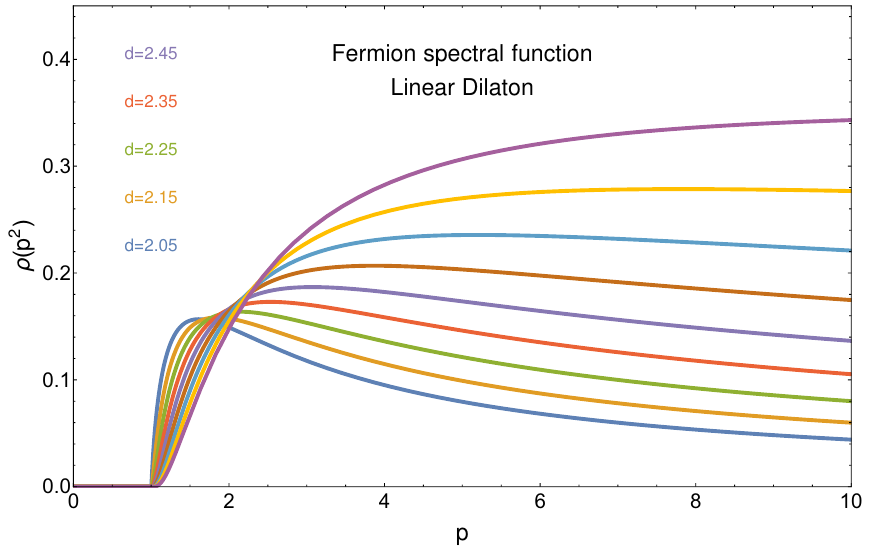
Figure 3 . The spectral density for a continuum Weyl fermion modeled in a linear dilaton back- ground. The quasi-anomalous dimension d is linked to the bulk mass by the relation d = c + 2. p where (cid:1) = y 2 (cid:22) 2 (cid:0) p 2 and W ( a; b; z ) is a Whittaker function. From these bulk